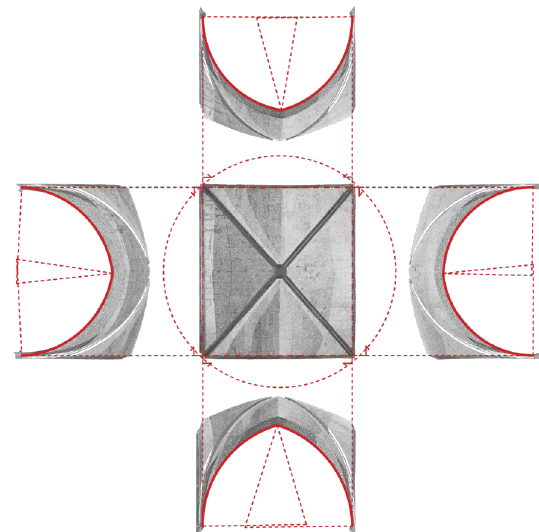
Figure 13 . Definition of curvatures and centres of perimetral arches of one of the vaults of Santa